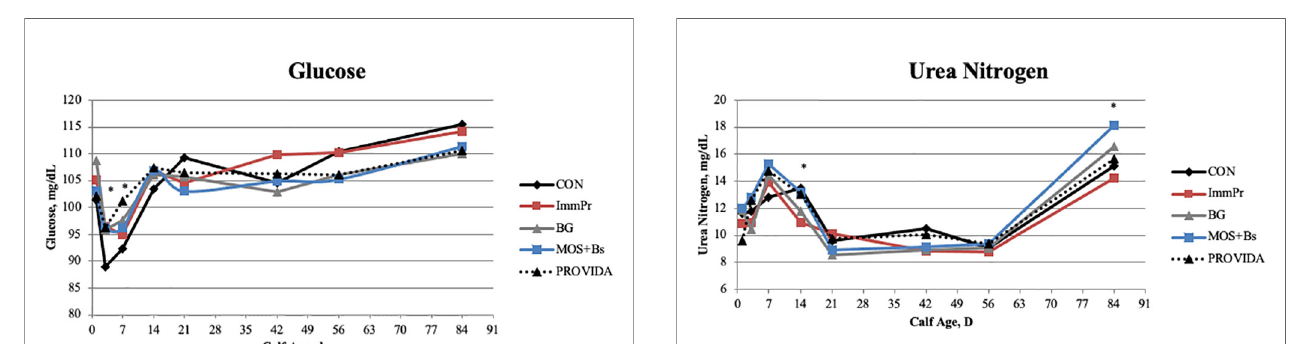
FIGURE 1 | Serum glucose concentrations were measured on d 0, 3, 7, 14, 21, 42, 56, and 84. There was a treatment x time interaction ( P = 0.049). The CON treatment had lower glucose concentrations than all other treatments on d 3 ( P ≤ 0.006) and was reduced on d 7 when compared to PROVIDA ( P = 0.009). Largest SEM per time point are expressed as mg/dL and include 3.727, 2.271, 3.051, 2.571, 2.739, 3.131, 3.149, and 2.933 for d 1, 3, 7, 14, 21, 42, 56, and 84, respectively. An * indicates a treatment difference of ( P ≤ 0.05) when treatments were sliced by time.